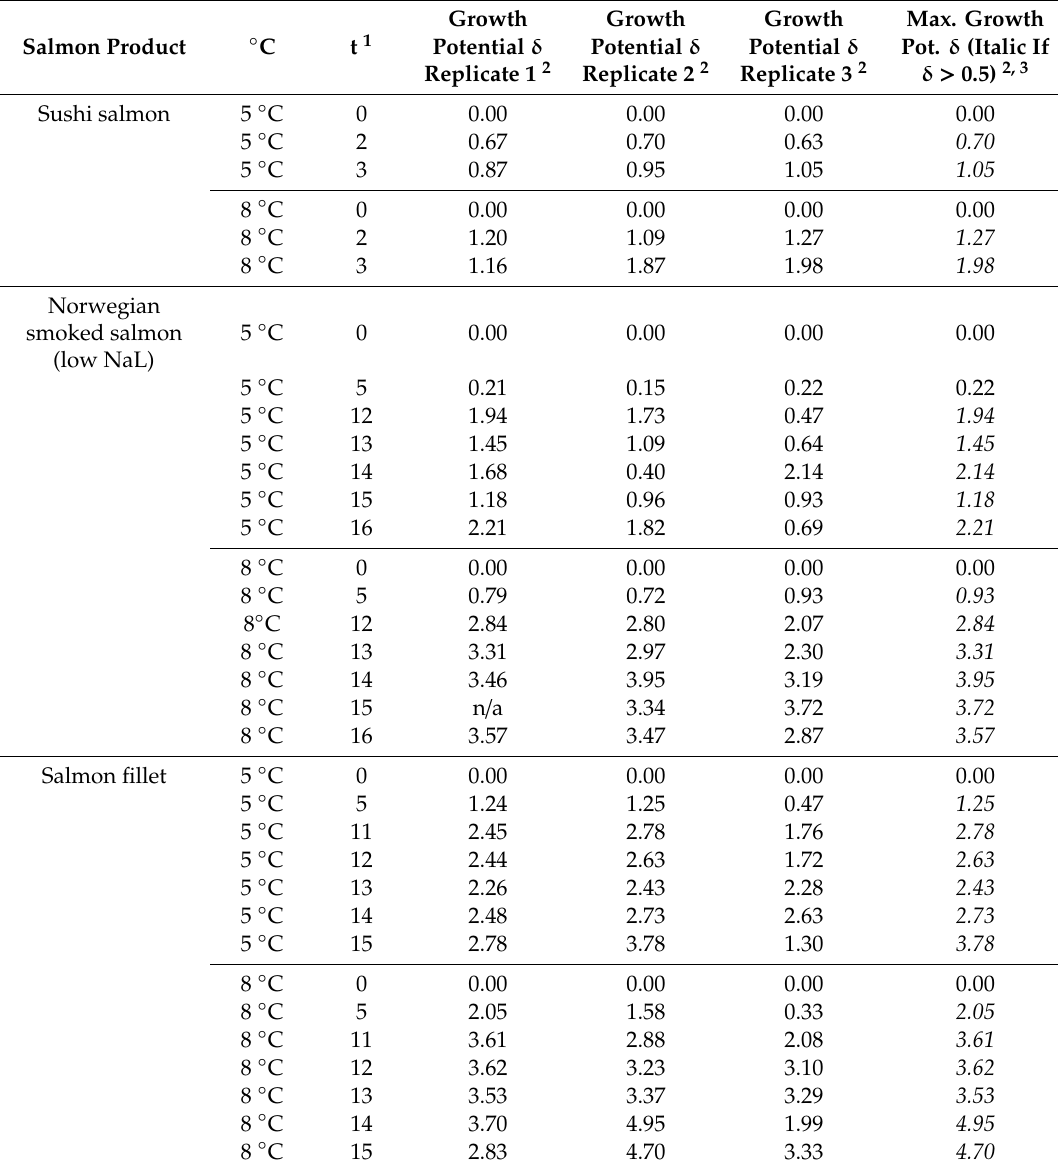
Table 3. Growth potential δ of L. monocytogenes in salmon products according to Commission Regulation (EC) No 2073 /